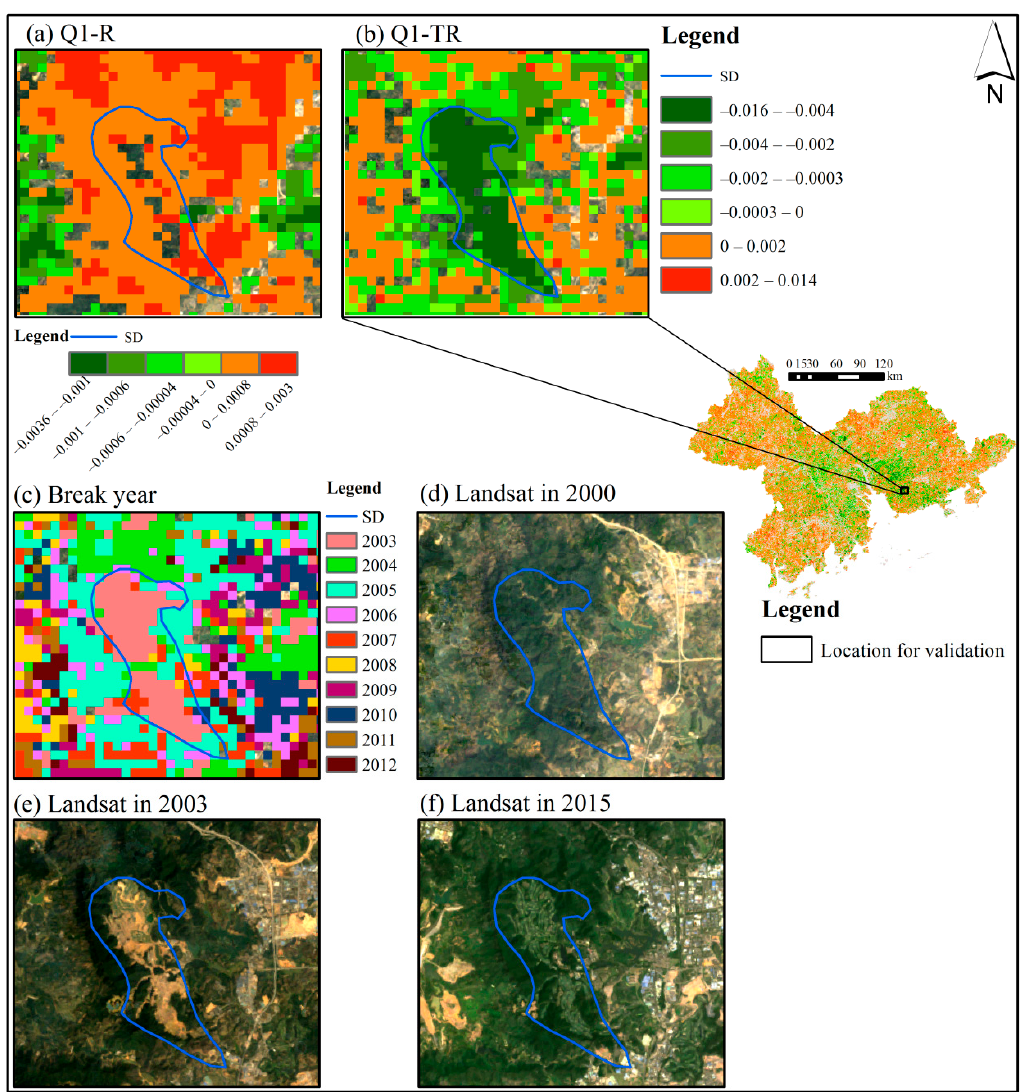
Figure 13. Comparison of Q1-R, Q1-TR, and Landsat: ( a ) result of Q1-R in the location of validation; ( b ) result of Q1-TR in location of validation; ( c ) Break year in location of validation; ( d ) Landsat image in 2000; ( e ) Landsat image in 2003; and ( f ) Landsat image in 2015; SD indicates a significant decrease.